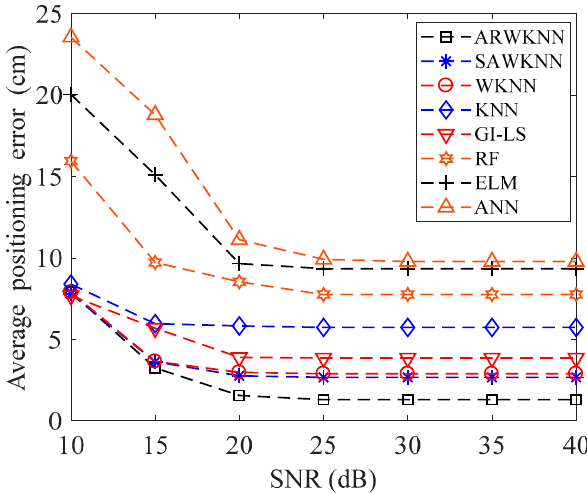
Figure 8. The impact of SNR on the average positioning error with K max = 4.